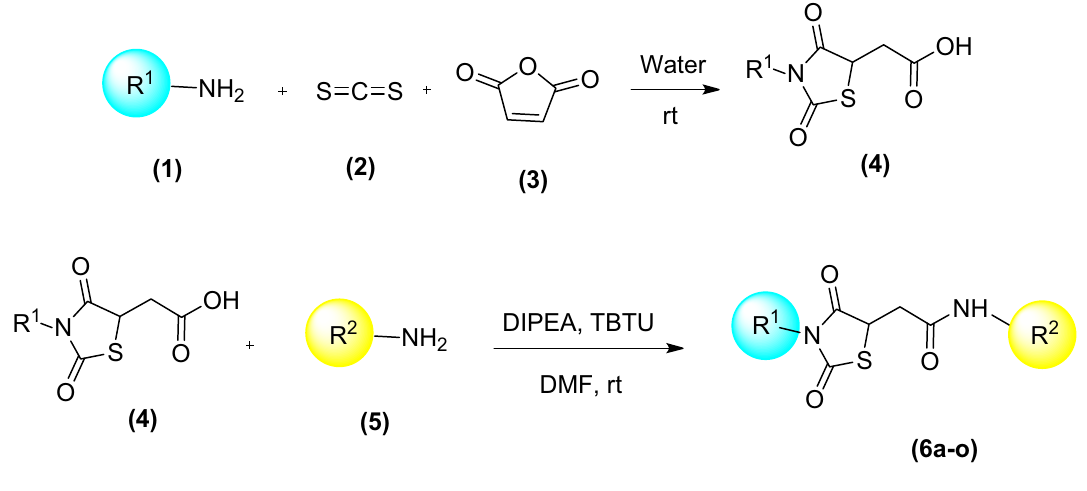
Figure 2. Synthesis of thioxothiazolidinyl-acetamide compounds